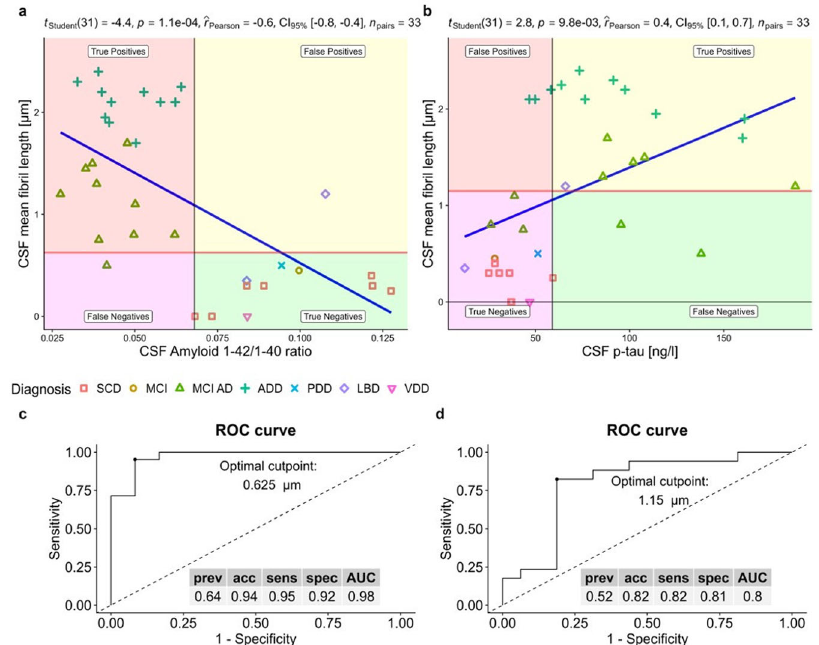
Fig. 4 CSF fi bril length as a potential biomarker of AD pathology. Scatterplots of the individual mean fi bril length in CSF plotted against the CSF Amyloid 42/40 ratio ( a ) and CSF p-tau levels ( b ) as well as the respective Pearson regression results. c , d Depict the ROC analyses and diagnostic performance measures of CSF fi bril length for detecting Amyloid-pathology as determined by a CSF Amyloid 42/40 ratio < 0.068 ( c ), respectively Tau pathology de fi ned as CSF p-tau levels >59 ng/l ( d ). The respective cutoffs were set at the highest Youden-index. The CSF fi bril length was signi fi cantly, inversely correlated with the CSF Amyloid 42/40 ratio ( r = − 0.62, p > 0.001, see a ) and positively correlated with CSF p-tau ( r = 0.45, p > 0.001, see b ). When applying a fi bril length cutoff of ≥ 0.625 µ m (horizontal red line in a ) the Amyloid pathology could be determined with an accuracy of 94% (sensitivity: 0.95, speci fi city: 0.92, see c ). Regarding Tau-pathology, a cut-off of ≥ 1.15 µ m (highest Youden index) predicted Tau status with an accuracy of 82% (sensitivity: 0.82, speci fi city: 0.81, see d ). (prev: prevalence, acc accuracy, sens sensitivity, spec speci fi city, AUC area under the